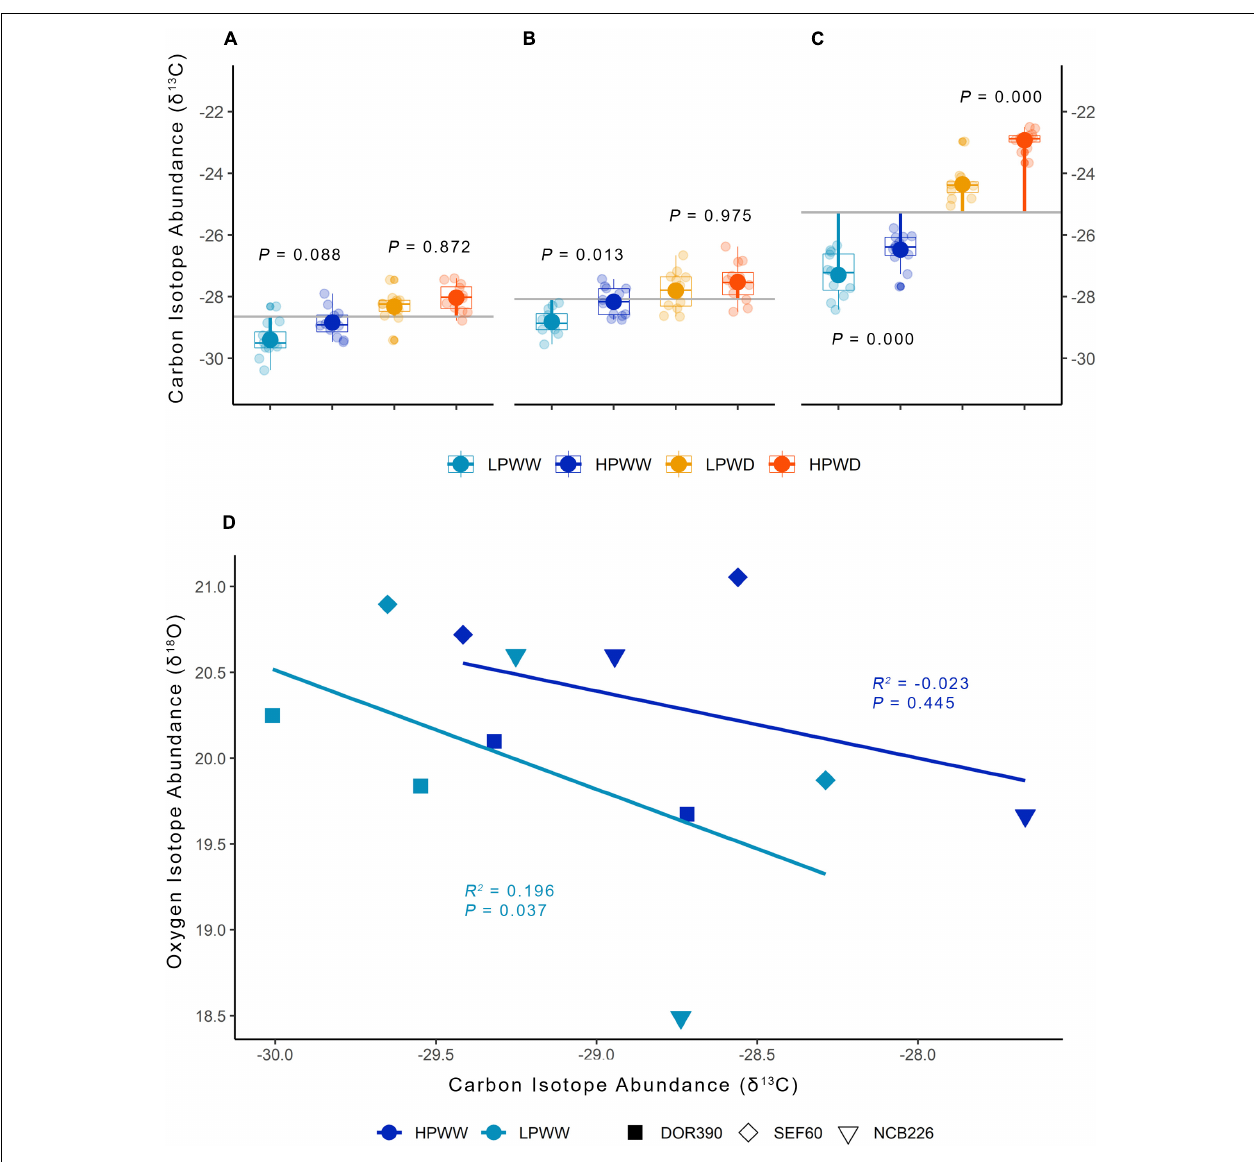
FIGURE 4 | Carbon isotope abundance ( δ 13 C) for bulk leaf tissue at flowering (A) , mid-pod fill (B) , and seed at harvest (C) for 12 common bean genotypes under treatments of low phosphorus well-watered (light blue), high phosphorus well-watered (blue), low phosphorus water deficit (yellow-orange), and high phosphorus water deficit (orange). The gray line represents the overall means across treatments at different development stages while segment lines represent the means per treatment showing the deviations from the overall means within the development stage. P values are according to treatment mean comparisons within the development stage calculated using the HSD test at A = 0.05. Multiple comparisons between treatments are provided in Supplementary Table 5 . (D) Carbon isotope abundance ( δ 13 C) and oxygen isotope abundance ( δ 18 O) for bulk leaf samples under treatments of low phosphorus well-watered (light blue) and high phosphorus well-watered (blue) for selected lines DOR390 ( filled square ), SEF60 ( diamond ), and NCB226 ( inverted triangle ) sampled at flowering and mid-pod fill stage; mean values adjusted for treatment and development stage. Linear regression to calculate adjusted R 2 and P values grouped according to